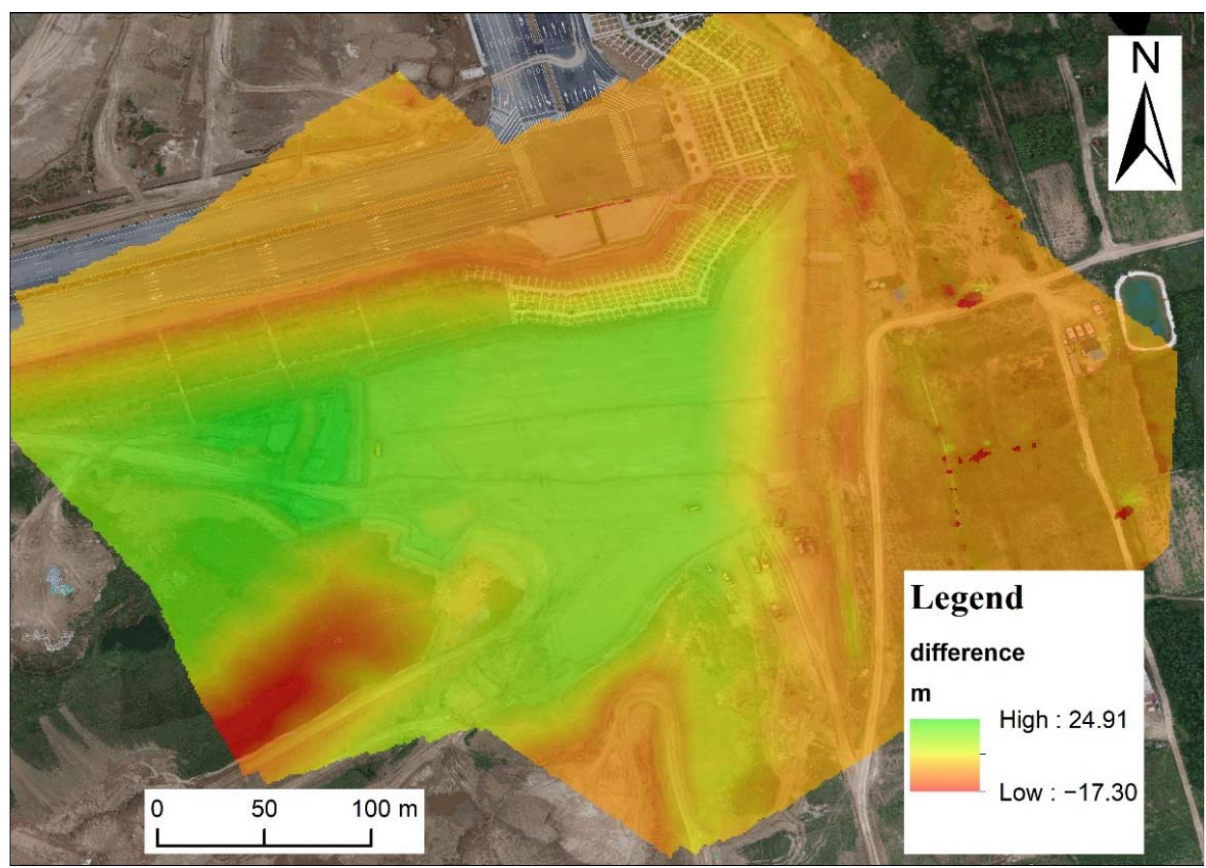
Figure 2. DEM differences before and after filling in the study area (positive value represent filling height and negative values represent excavation depth).